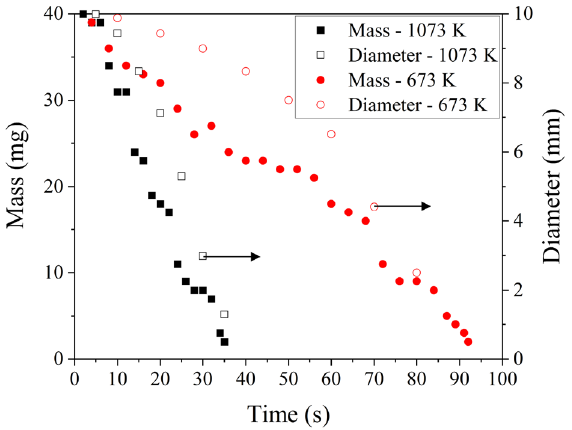
2 2 / 3 ) and particle mass ( m ) with normalized 2 0 behavior (( c ) 2 0 behavior (( d ) corresponding mass loss profile). (error in